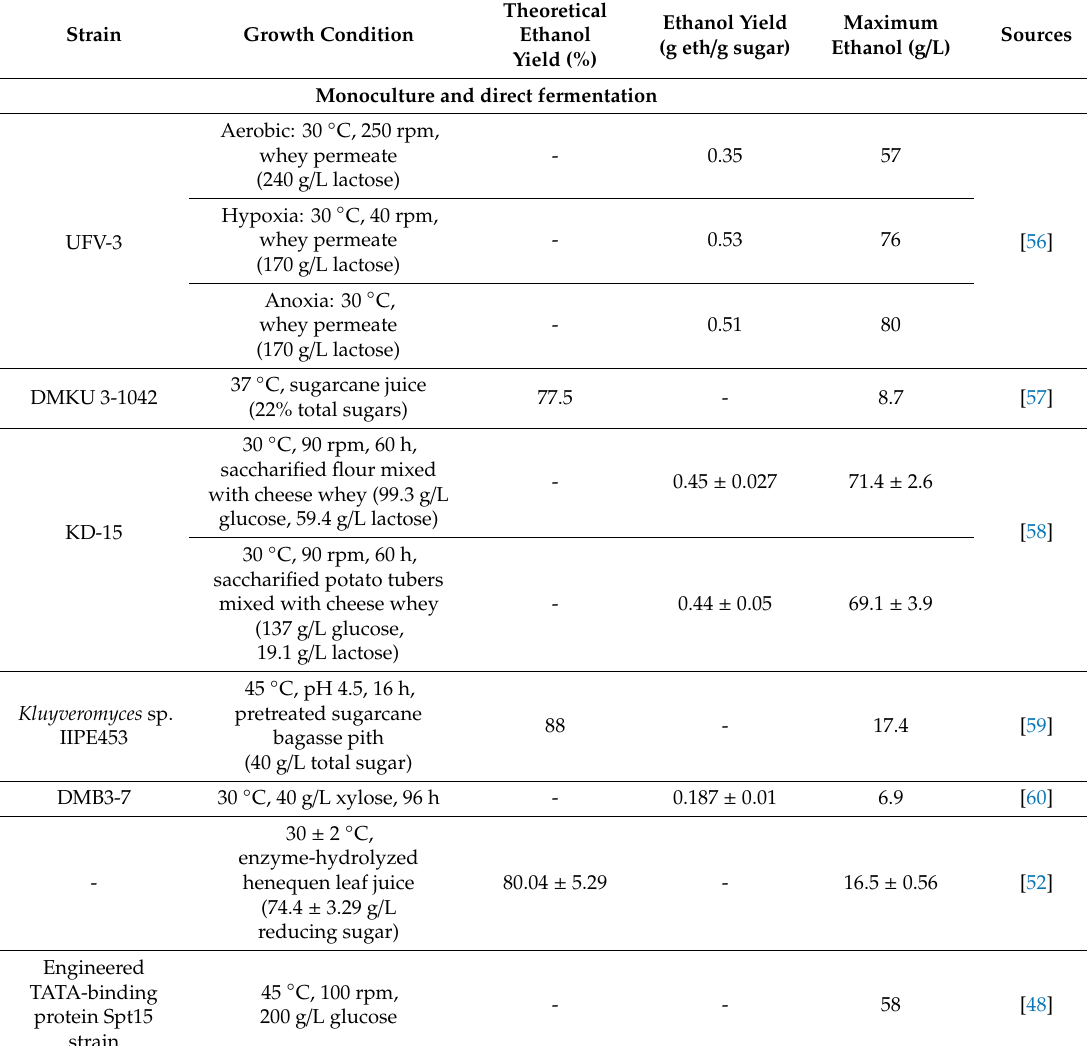
Table 2. Monoculture, co-culture of K. marxianus with other microbes and other fermentation processes for bioethanol